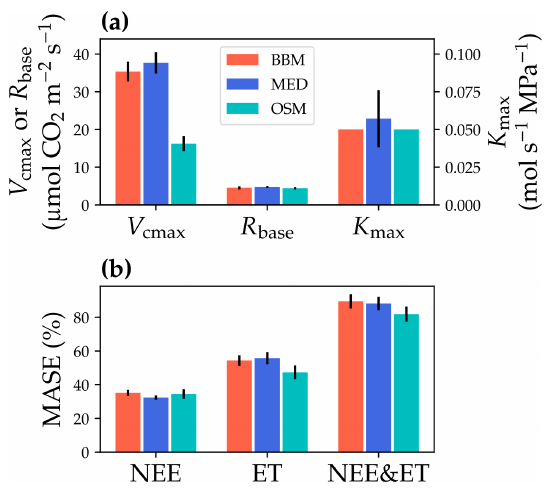
Figure 11. Comparisons of the fitted model parameters and model predictive skills for the US-MOz (MOFLUX, deciduous an- giosperm forest) flux tower. (a) The red bars plot the mean of the fitted parameters for the Ball et al. (1987) stomatal model (BBM). The fitting parameters are the maximal carboxylation rate at 25 ◦ C ( V cmax25 ), the soil respiration rate at 25 ◦ C ( R base ), and the maxi- mal whole-plant hydraulic conductance ( K max ). The blue and cyan bars plot the means for the Medlyn et al. (2011) (MED) and Wang et al. (2020) (OSM) models, respectively. Black error bars plot the standard deviation of the fitting parameter. The fitted K max of the BBM and MED reaches the maximum limit of the K max ranges (4molH 2 Os − 1 MPa − 1 ) and is way higher than that of the OSM; thus, the bars are cut off for comparison with the OSM. (b) Com- parison of mean absolute standardized error (MASE, Eq. 12) for the carbon flux (NEE), water flux (ET), and both NEE and